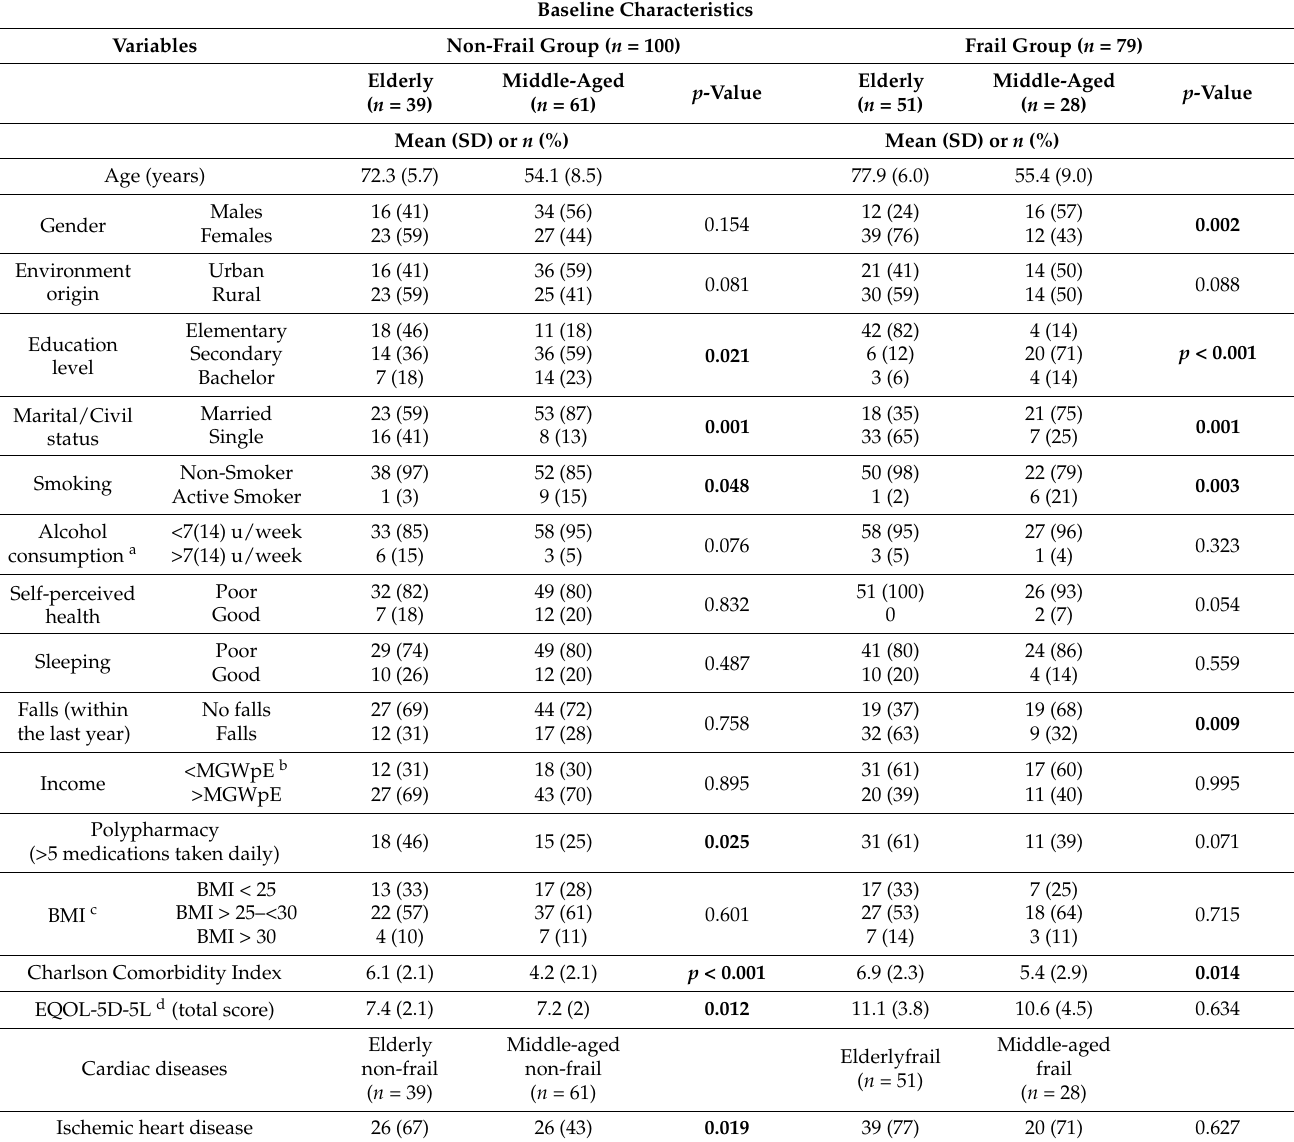
Table 1. Baseline characteristics of the sample included in the analysis. Quantitative variables are expressed as mean (M) and standard deviation (SD), and qualitative variables as a percentage. Baseline